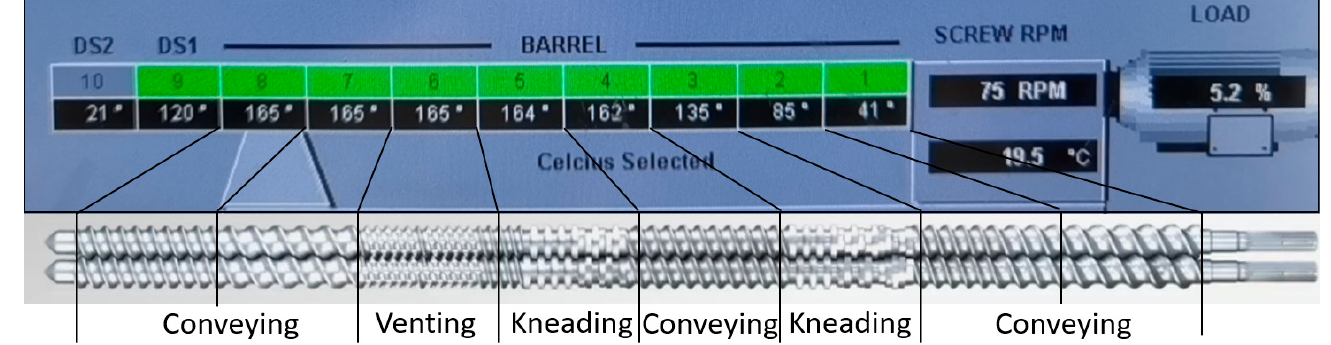
Figure 1. The screw configuration and temperature profiles of the extrusion process.